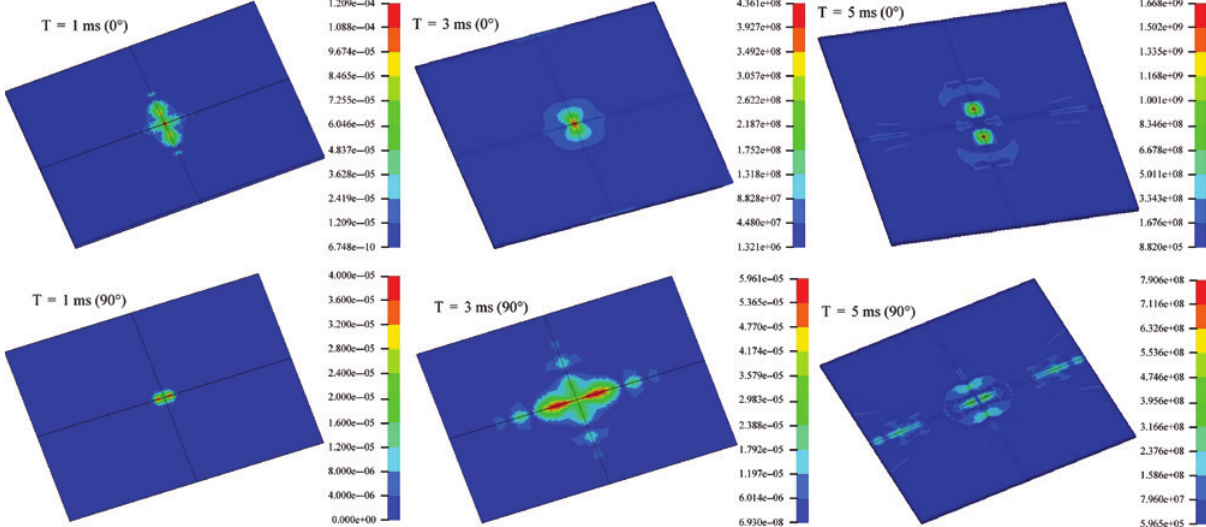
Figure 13: The Von Mises stress at different times.